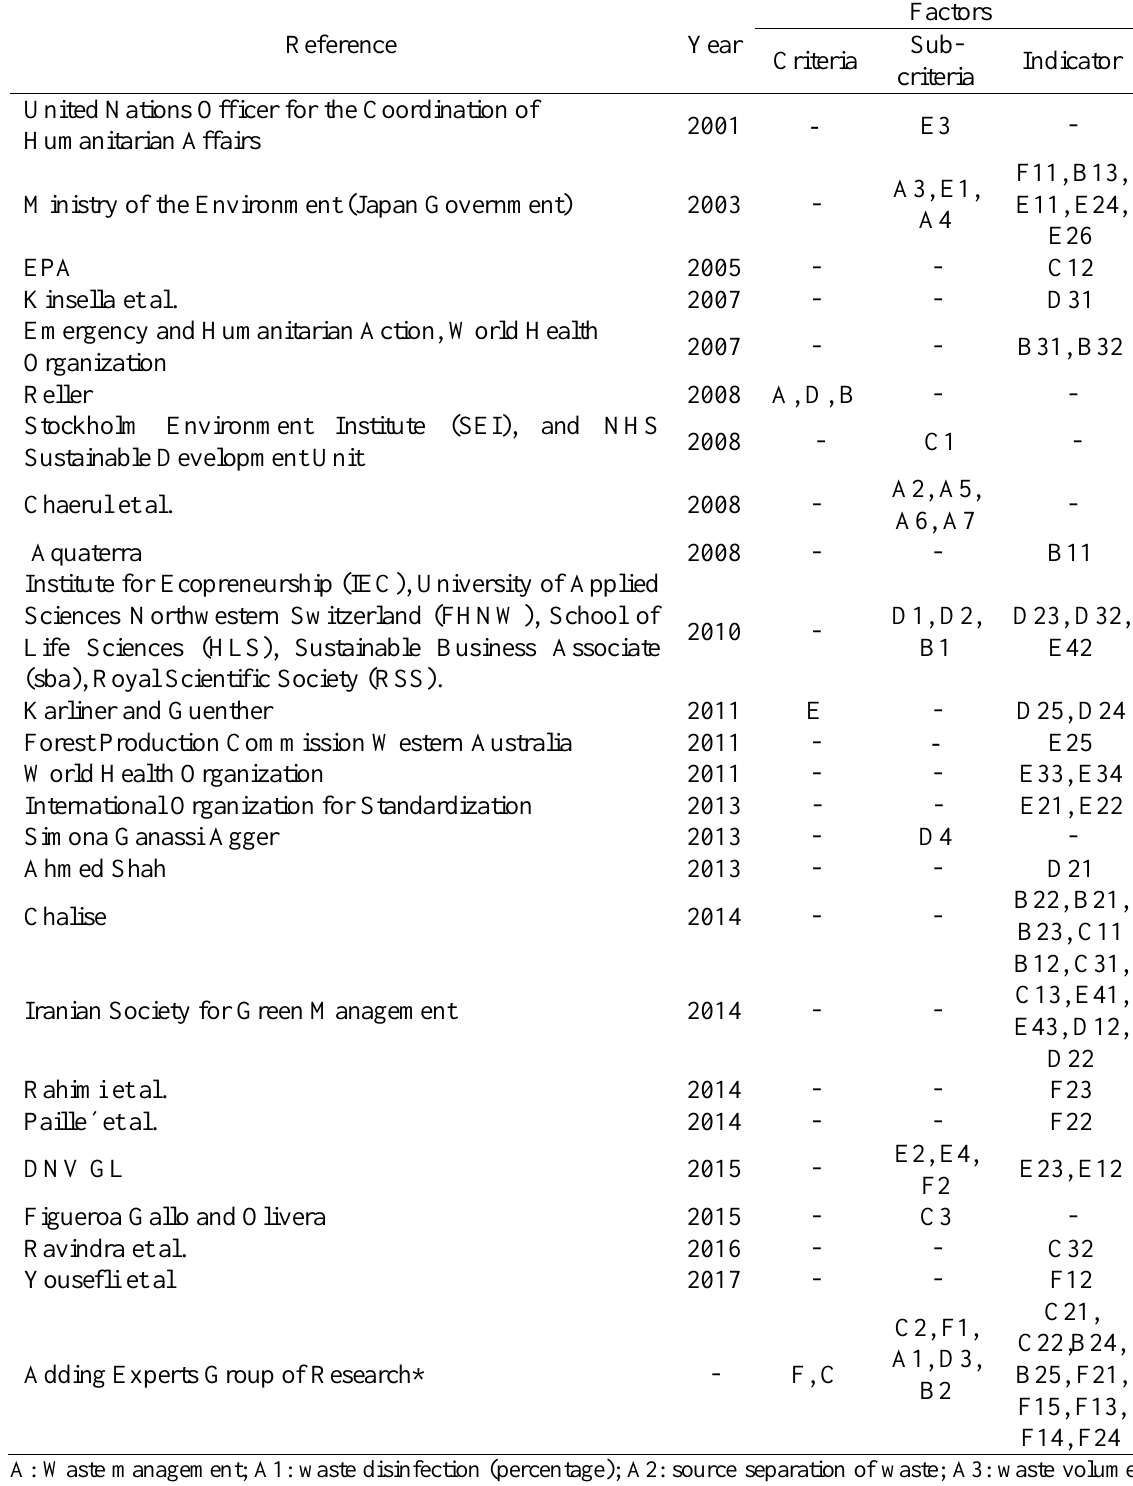
Table 1 . Sources for identifying criteria, sub-criteria and indicators for environmental performance